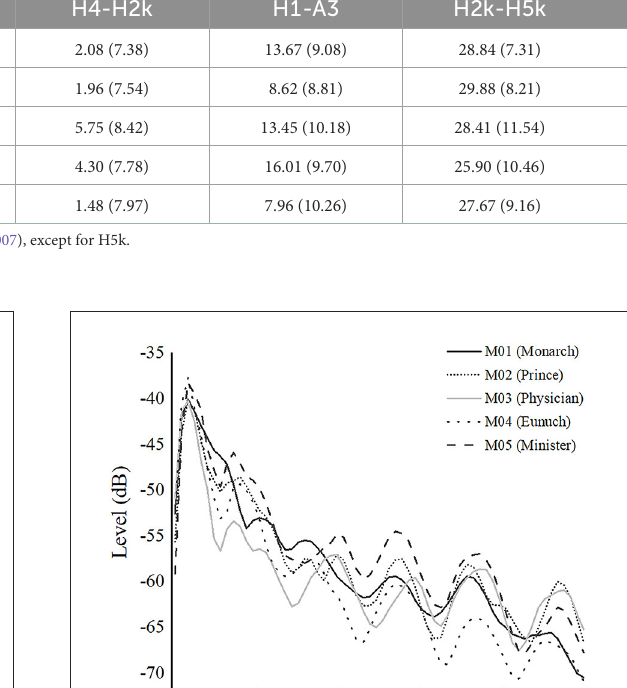
FIGURE4 Harmonic measures of the five characters.